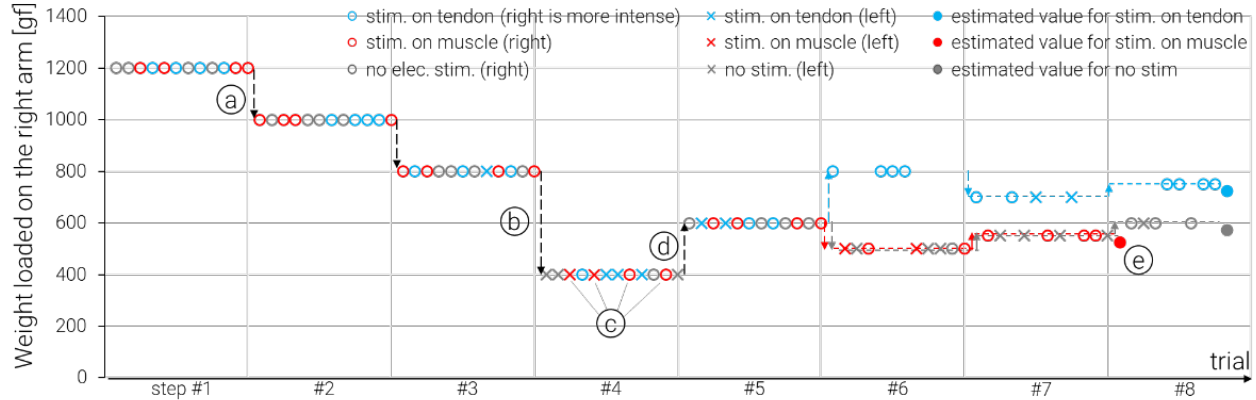
Figure 1. ( a ) Electrodes’ position. A pair of electrodes is put above the biceps muscle of the left arm, and the other pair is put over the tendon and the junction between the muscle and tendon. ( b ) Experimental setup for comparison of force sensation. ( c ) A conceptual side view of ( b ).